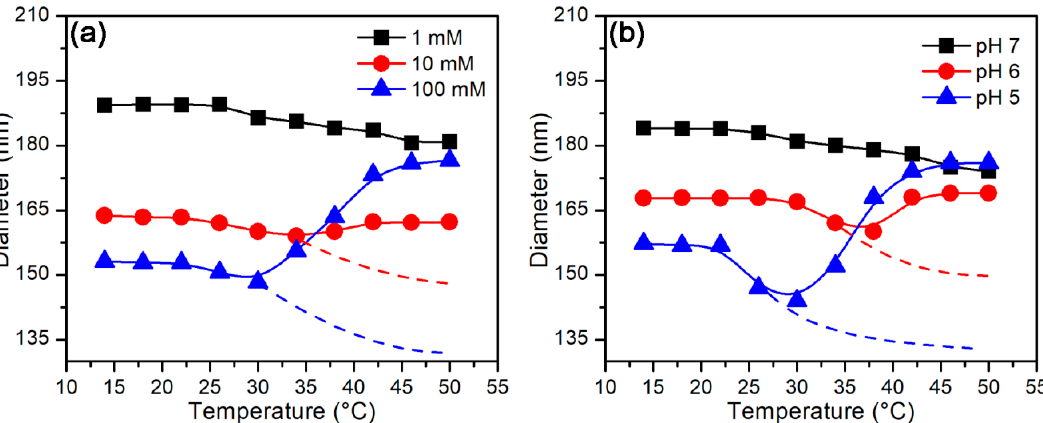
Figure 4. Effect of temperature on hydrodynamic diameters of PSV@PAA- b -PNIPA ( a ) in different ionic strength at pH of 7.4 and ( b ) at different pHs in 1 mM phosphate-buffered saline (PBS). Dashed lines represent the expected trends.